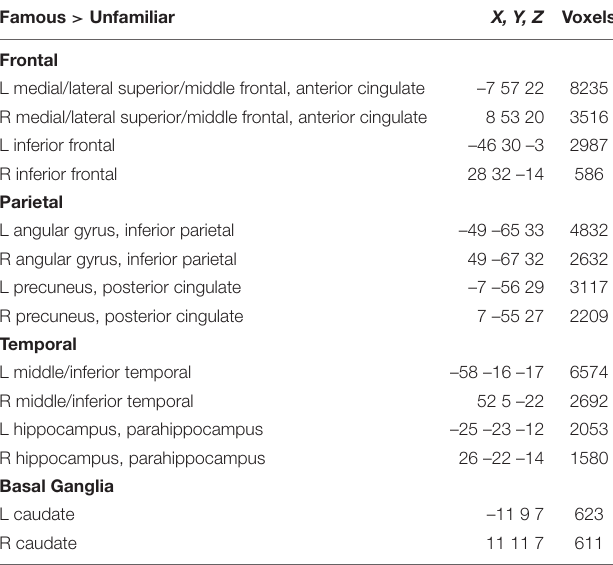
TABLE 2 | Regions of interest showing greater famous than unfamiliar activation in voxelwise analyses. Famous >